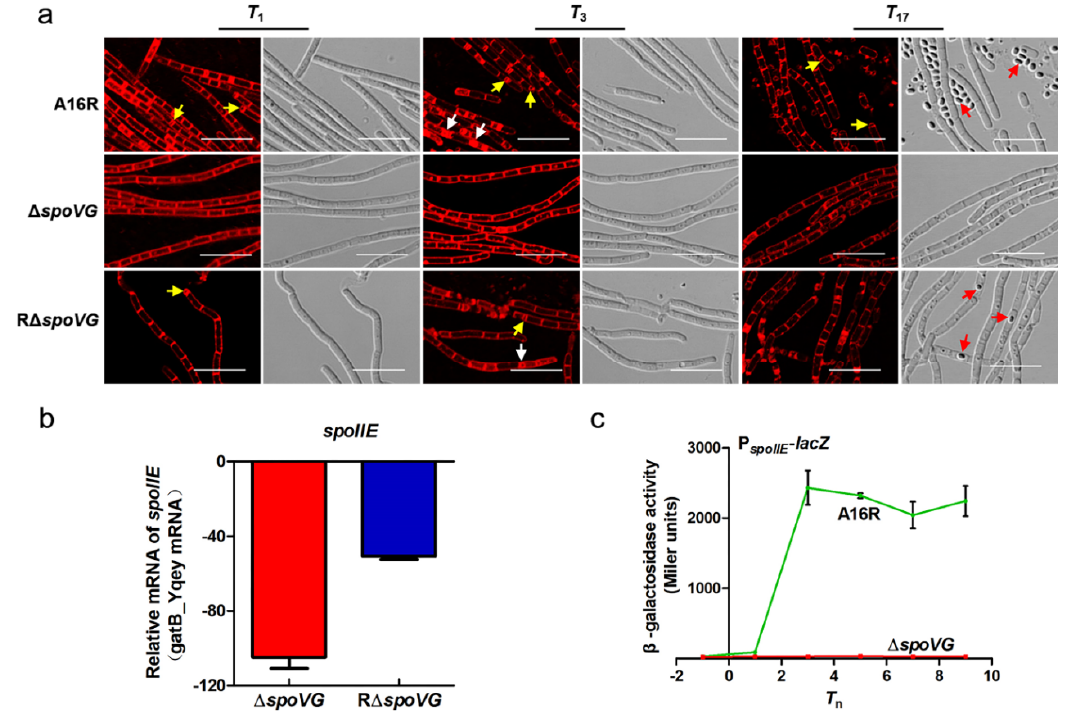
Figure 3. Defects in the formation of asymmetric septum in the B. anthracis ∆ spoVG strain are associated with low transcriptional levels of spoIIE . ( a ) Confocal laser-scanning micrograph (scale bar, 10 µ m) of the A16R (wild-type), ∆ spoVG , and R ∆ spoVG strains at T 1 , T 3 , and T 17 (37 ◦ C), T n being n hours after T 0 (the end of the exponential growth phase). The cell membrane is visible as red fluorescence. Yellow, white and red arrows indicate asymmetric septum, engulfed cells (prespores), and mature spores, respectively. ( b ) Relative mRNA expression of spoIIE determined in the ∆ spoVG and R ∆ spoVG strains compared with A16R (wild-type) cells at T 1 using RT-qPCR. Values represent means ± SDs of triplicate experiments. ( c ) Transcription of P spoIIE – lacZ in A16R (wild-type) cells (green line) and ∆ spoVG -mutant cells (red line) grown in DSM. Values represent the means of at least three independent replicates; error bars represent